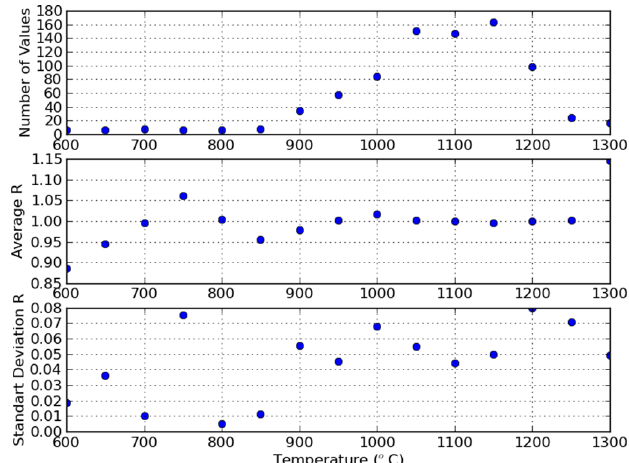
Fig. 5. Comparison of experimental and UJP-correlation data for each evaluated temperatures. Number of points, R -average, R - standard deviation.